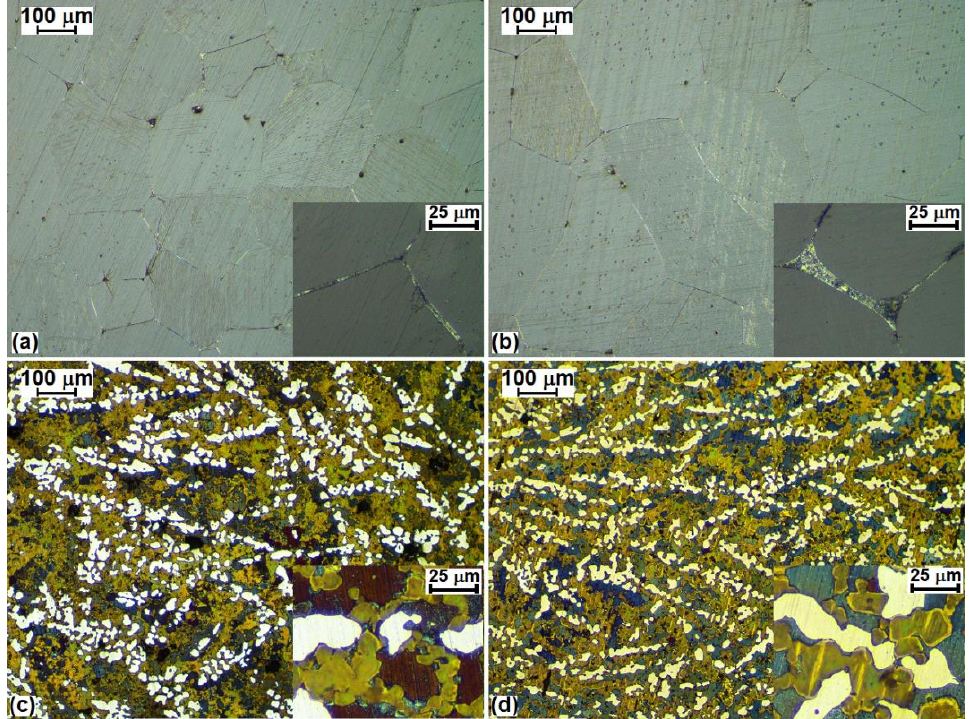
Figure 3. Optical microscopy of ST at 370 °C of ( a ) Zn-1Mg after 3 h and ( b ) 5 h, and ( c ) Zn-12.5Ag-1Mg after 3 h and ( d ) 5 h.